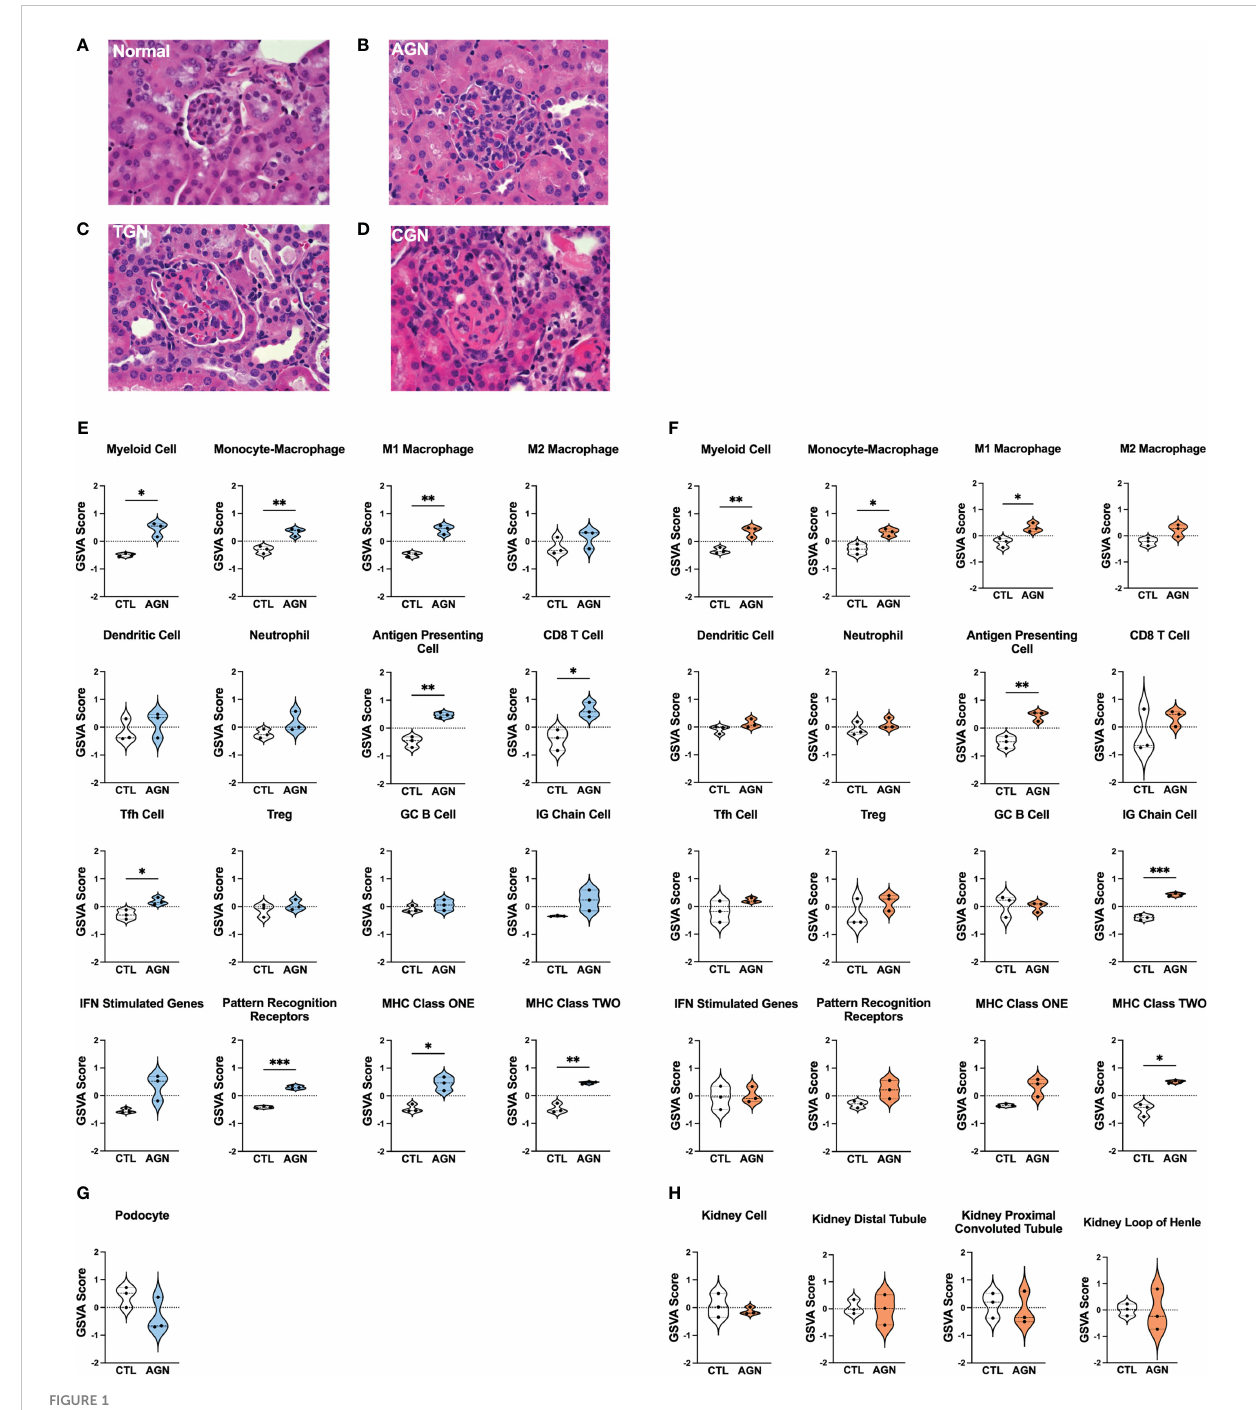
FIGURE 1 Histologic and transcriptional analysis of immune populations in NZM2328 mice with GN. (A-D) H&E staining of kidneys from normal/CTL (A) NZM2328 females and mice with acute (B) , transitional (C) , and chronic (D) stage GN. Individual sample gene expression from glomeruli (E, G) and TI (F, H) of CTL and AGN mice was analyzed by GSVA for enrichment of immune cells/in fl ammatory pathways (E, F) and kidney tissue cells (G, H) . Enrichment scores are shown as violin plots. *p<0.05, **p<0.01,